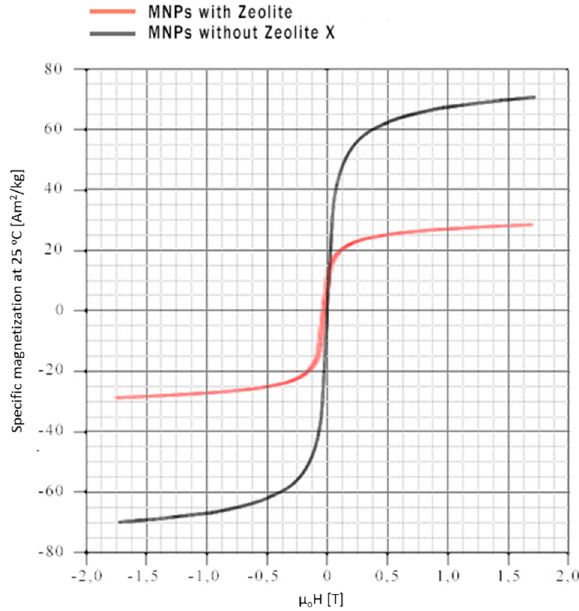
Figure 7. Hysteresis loops for the magnetite (MNPs) and the composite particles obtained by VSM .